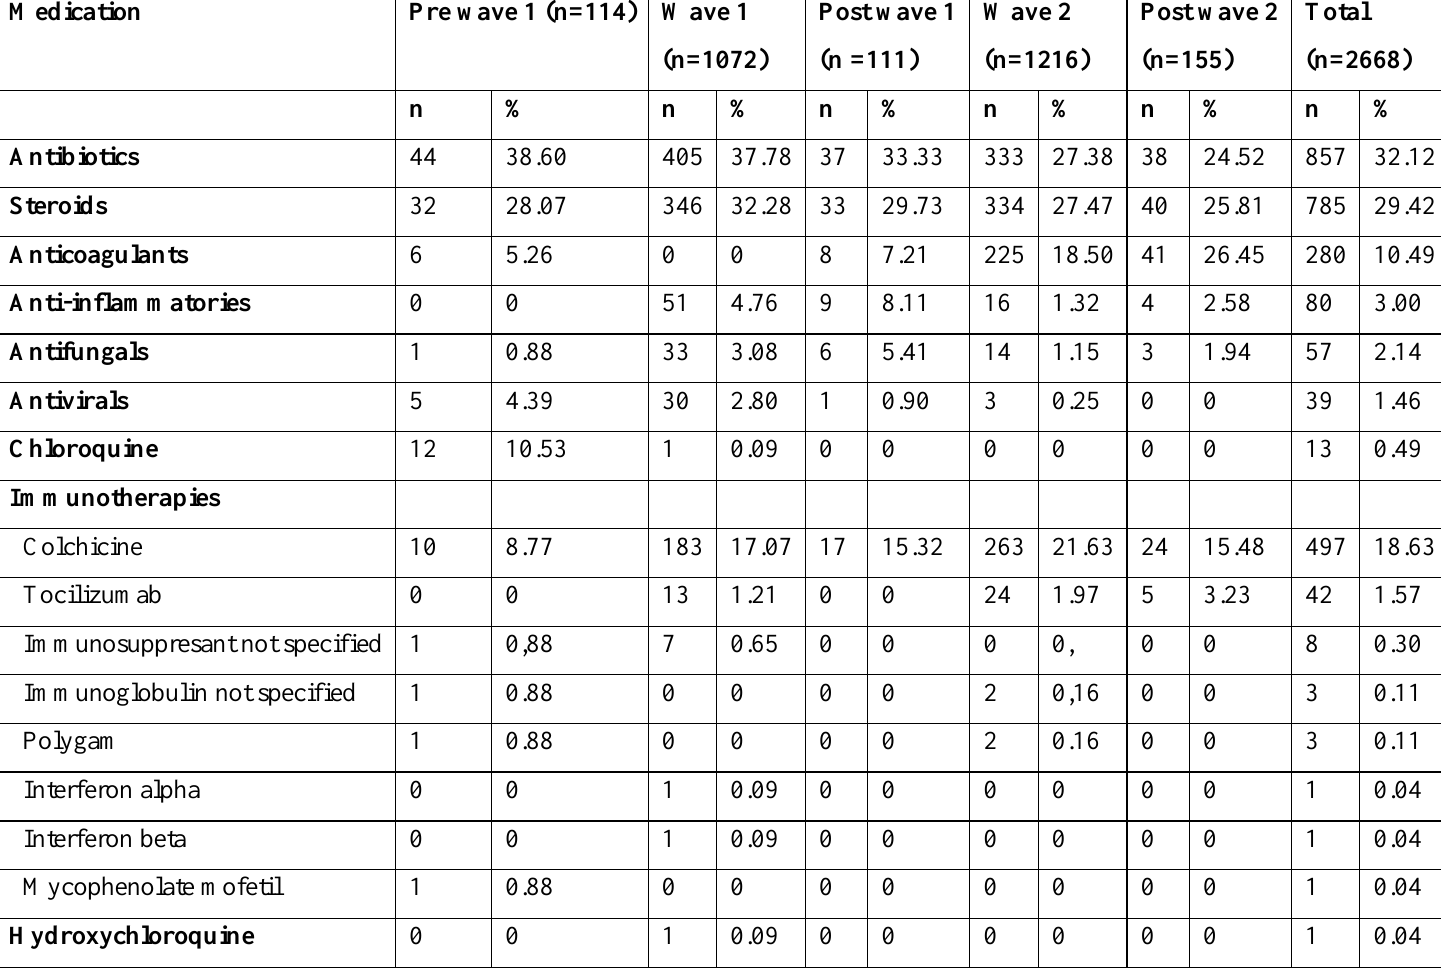
Table 1. Medication used by COVID-19 cases during admission, Charlotte Maxeke Hospital, 05 March 2020 - 27 March 2021 Medication